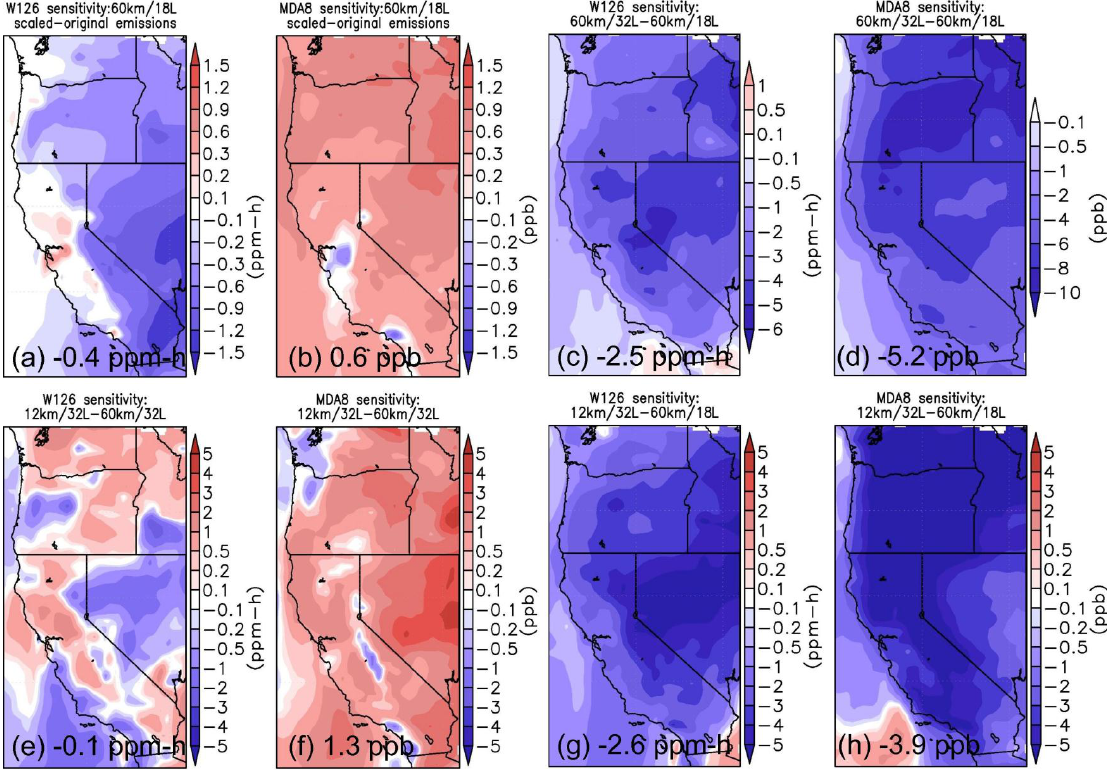
15 Fig. 6. Differences of SEN1 (defined in Fig. 5 caption) for (a,c,e,g) W126 and (b,d,f,h) MDA8 between the cases of (a–b) using the scaled and original US anthropogenic emissions in the 60km/18 layer grid; (c–d) in 60km/32 layer and 60km/18 layer grids; (e–f) in 12km/32 layer and 60km/32 layer grids; and (g–h) in 12km/32 layer and 60km/18 layer grids. Numbers besides the labels are mean differences in the sensitivities over the plotted